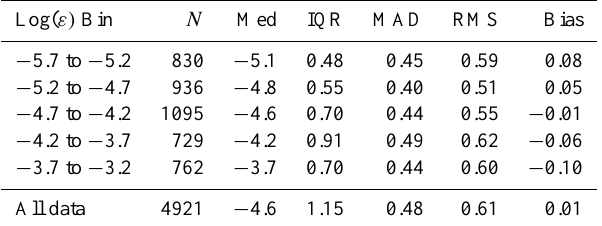
Table 3. Statistics comparing radar retrievals of dissipation rate with in situ observations from aircraft at MPACE. All details are similar to Table 2 with the statistics computed for the radar retrievals within bin ranges defined by the aircraft values. A positive bias indicates that the radar retrieval is larger than the aircraft